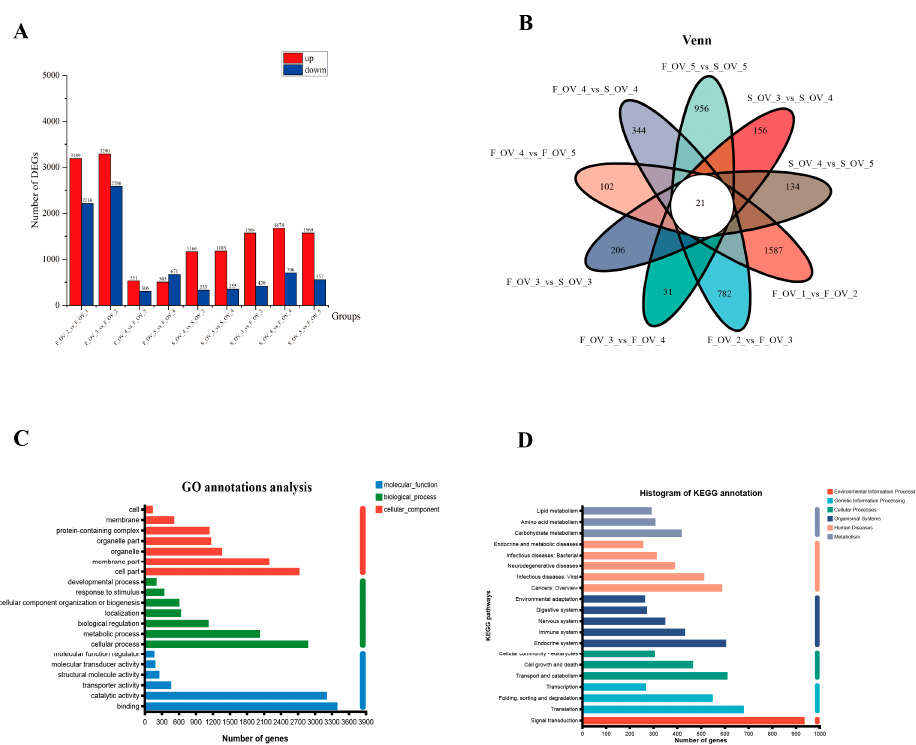
Figure 4. Annotation of the DEGs in the GO and KEGG databases. ( A ) The number of DEGs in the different comparison groups. ( B ) Venn diagram of the DEGs from different comparison groups. ( C ) GO annotation of total DEGs. ( D ) KEGG annotation of total DEGs.